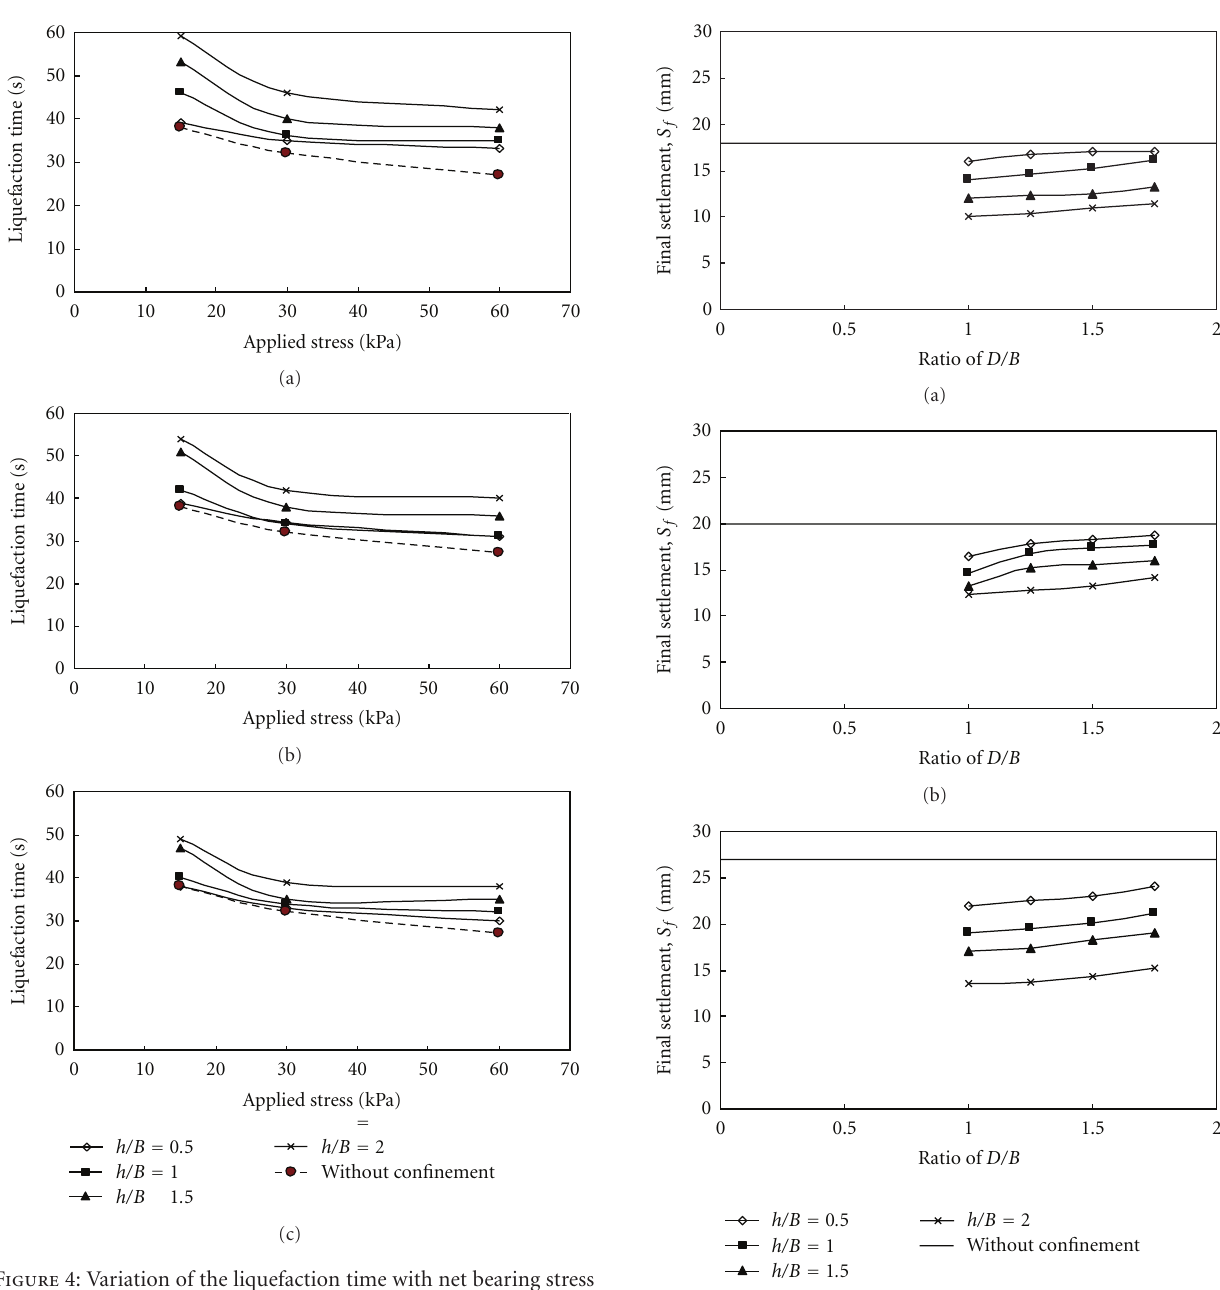
Figure 4: Variation of the liquefaction time with net bearing stress at di ff erent cell dimension.